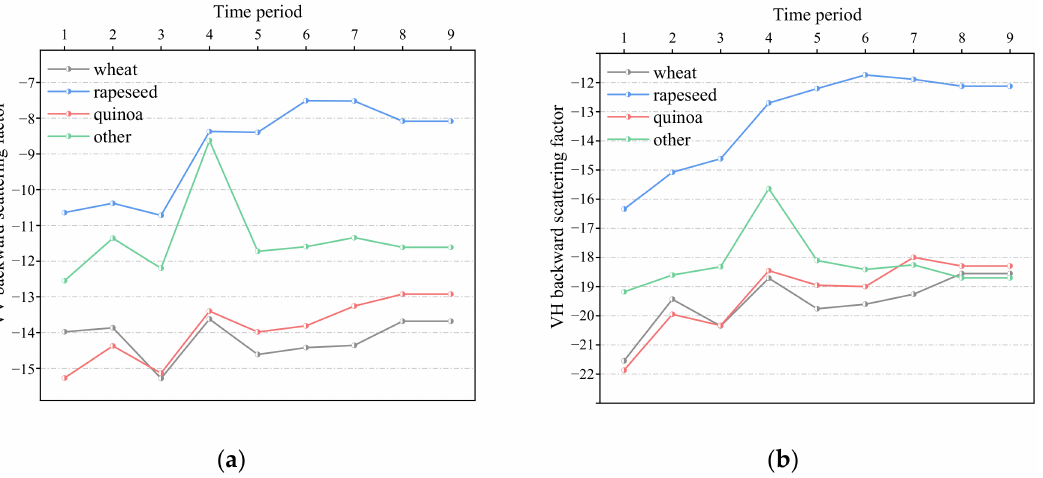
Figure 9. Polarization characteristic curves of different features. ( a ) VV polarization feature curve; ( b ) VH polarization feature